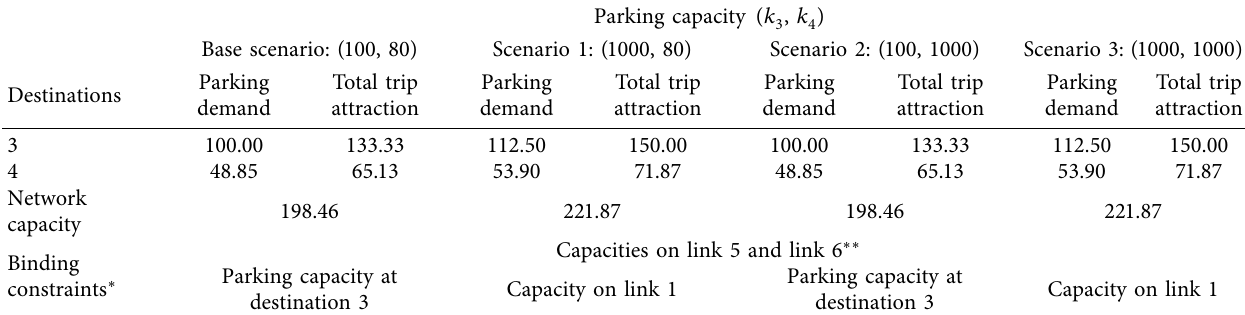
Table 7: Results of network capacity under different parking capacities.